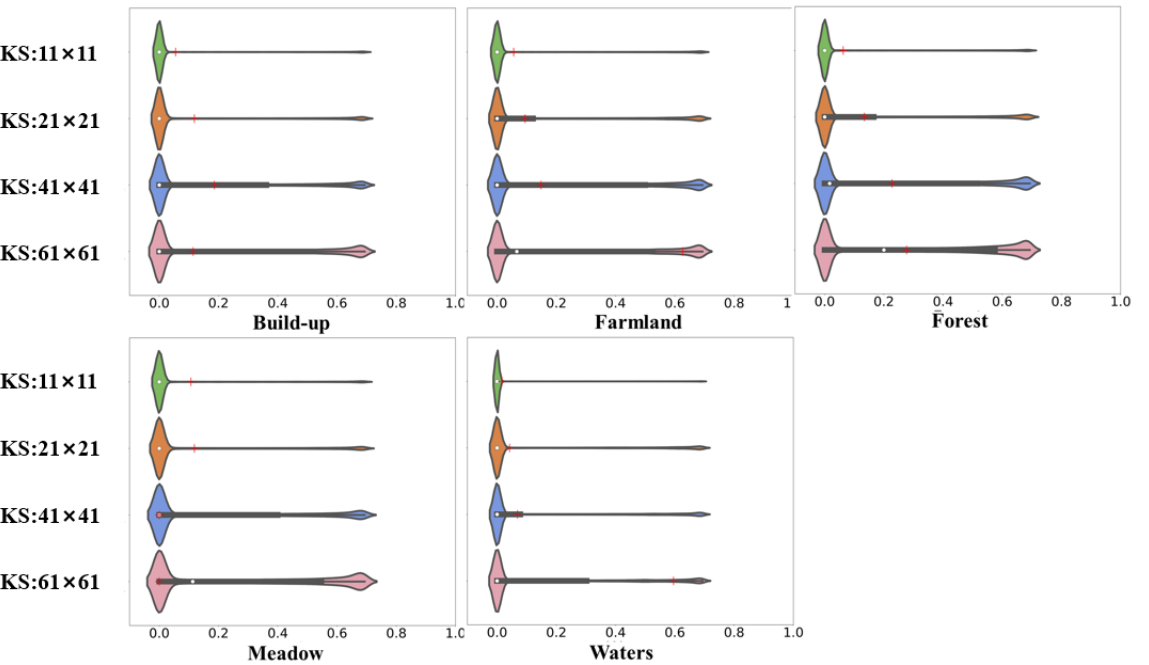
Figure 6. Violins of the local surface complexity extracted from the original images (4 × 4 m 2 ) with different kernel sizes (KZ: kernel sizes). The red plus sign indicates the average complexity score of the samples.